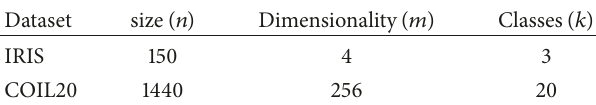
Table 6: Two data